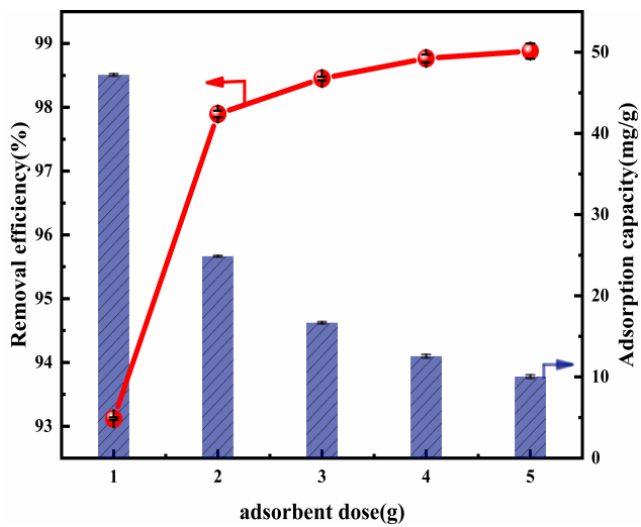
Figure 3. Cl − removal efficiency and adsorption capacity as a function of the adsorbent dosage (ion ratio Mg: Al = 6:1; Cl − initial concentration: 2000 mg L − 1 ; adsorption temperature: 293 K; contact time: 13 h).